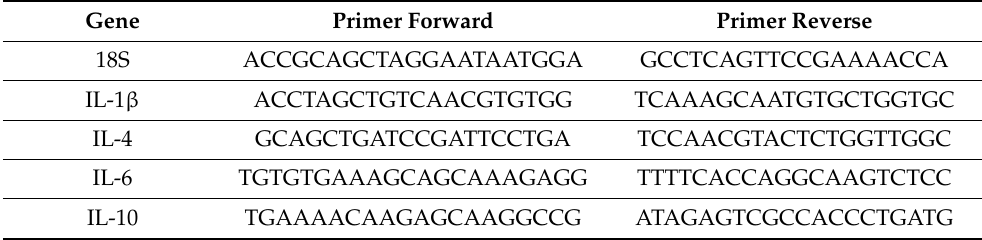
Table 2. Gene-specific oligonucleotide primers of inflammatory cytokines for RT-qPCR. Gene Primer Forward